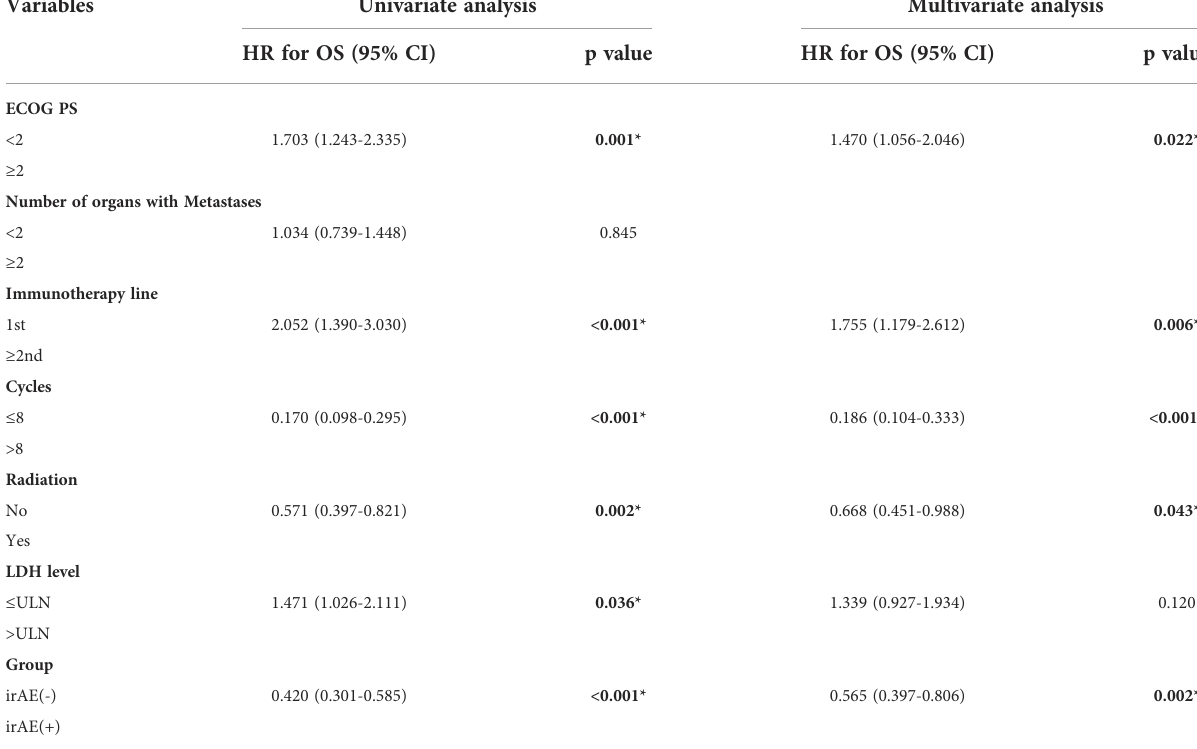
TABLE 4 Results of univariate and multivariate analyses showing factors affecting the overall survival.